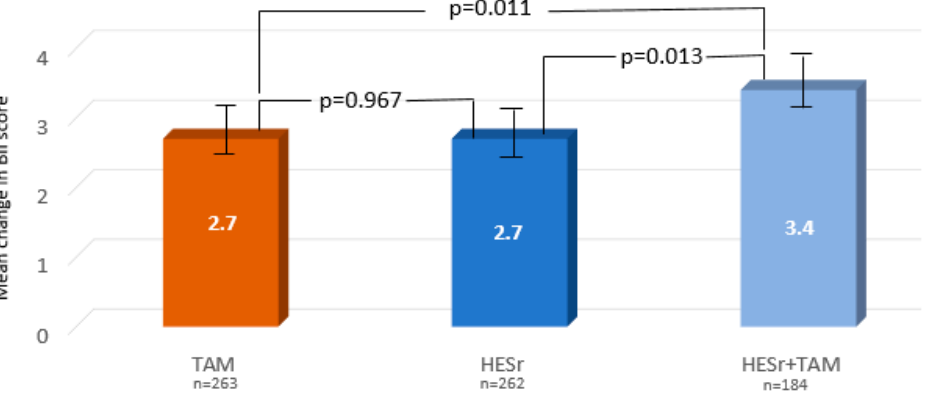
Figure 3. Mean improvement (95% confidence interval [CI]) in BII total score from baseline to 6 months. for the three treatment groups (paired comparisons between the 3 groups, ITT analysis). BII: BPH impact index; TAM: tamsulosin; HESr: hexanic extract of Serenoa repens . Student’s t -test.